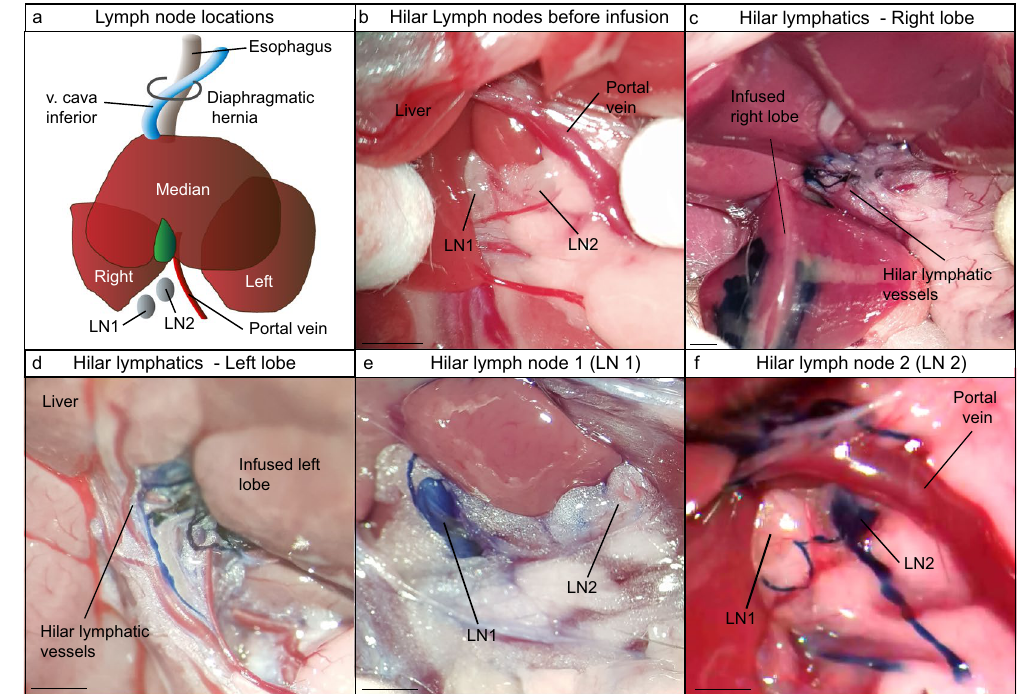
Figure 2. Murine liver lymphangiography model identifying hilar lymphatic vessels and lymph nodes. All C57Bl/6 mice (n = 57) had 2 hilar lymph nodes situated in the hepatoduodenal ligament. ( a ) Schematic overview of hilar lymph nodes (LN1 and LN2). ( b ) Representative image of hilar lymph nodes. ( c , d ) Liver lymphangiography was performed with 10% Evan’s blue dye into right lobe (n = 21), left lobe (n = 19) and median lobe (n = 17). Representative images of dye accumulating in hilar lymphatic vessels which can be seen to drain from the infused lobe towards the hilar region. ( e , f ) Representative images of dye accumulation in hilar LNs. All scale bars = 2 mm.